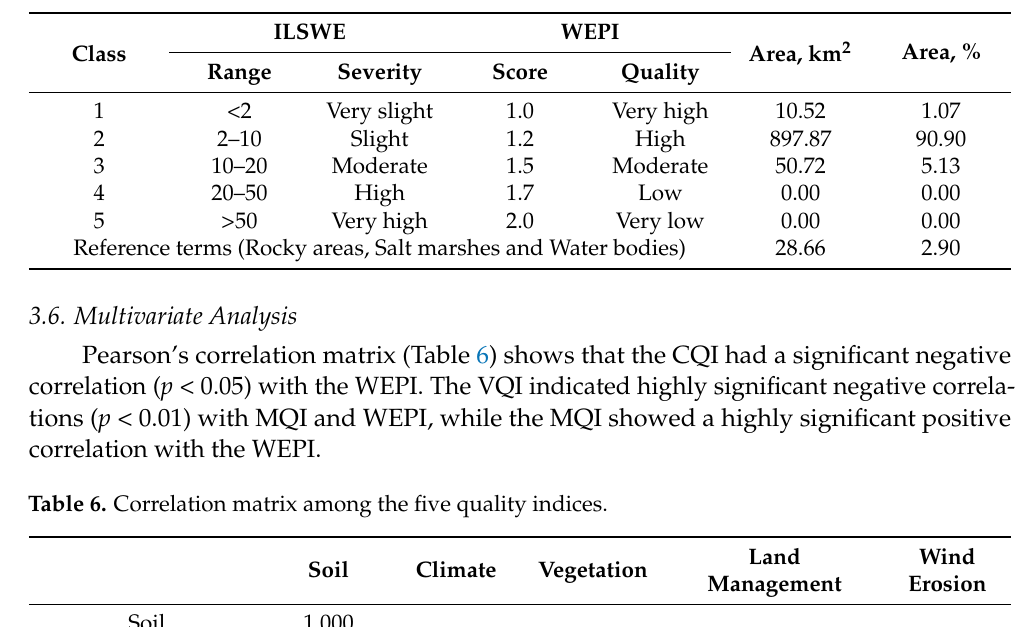
Figure 6. Index of land susceptibility to wind erosion and corresponding erosion protection index. Table 5. Classes and areas of the index of land susceptibility to wind erosion (ILSWE) and corre- sponding wind erosion quality index (WEPI).